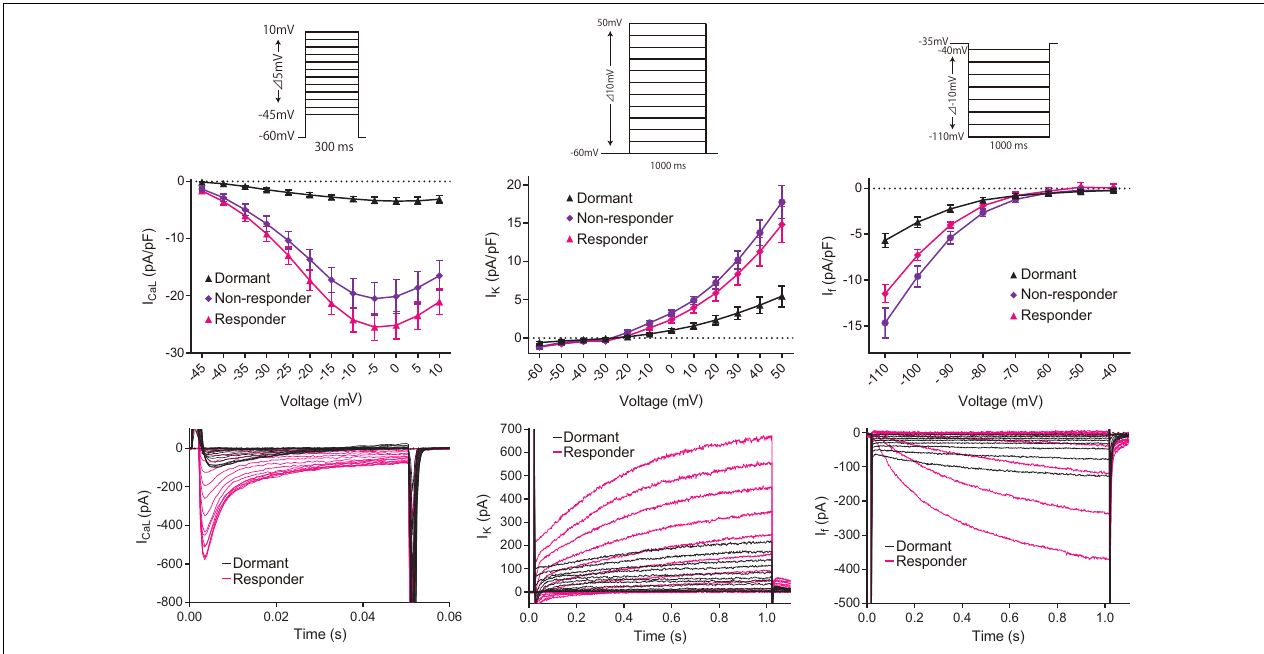
FIGURE 7 | Consecutive in-series measurements of ion-current density of L-type Ca 2 + current (left panels), K + current (center panels) and funny current (right panels) from SANC revealed that M-clock function of both responder (magenta) and non-responder (purple) dormant SANC increases in response to β -AR stimulation by 100 nM isoproterenol. The voltage protocol (same to those for Figure 1C ) is shown above the I-V curves. Example I–V curves for each current is shown in the bottom raw. The data shown are from different cells, one without isoproterenol (black) and one with isoproterenol (magenta).